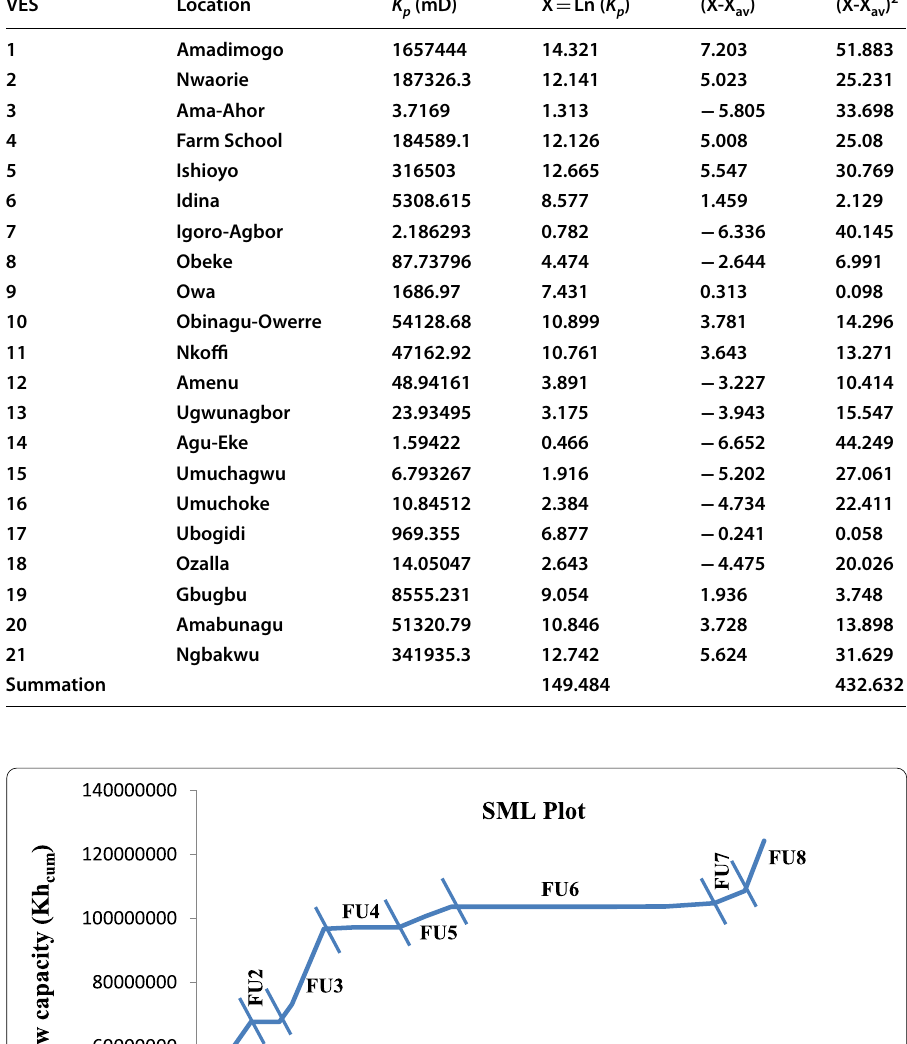
Table 2 Results of heterogeneity measurement